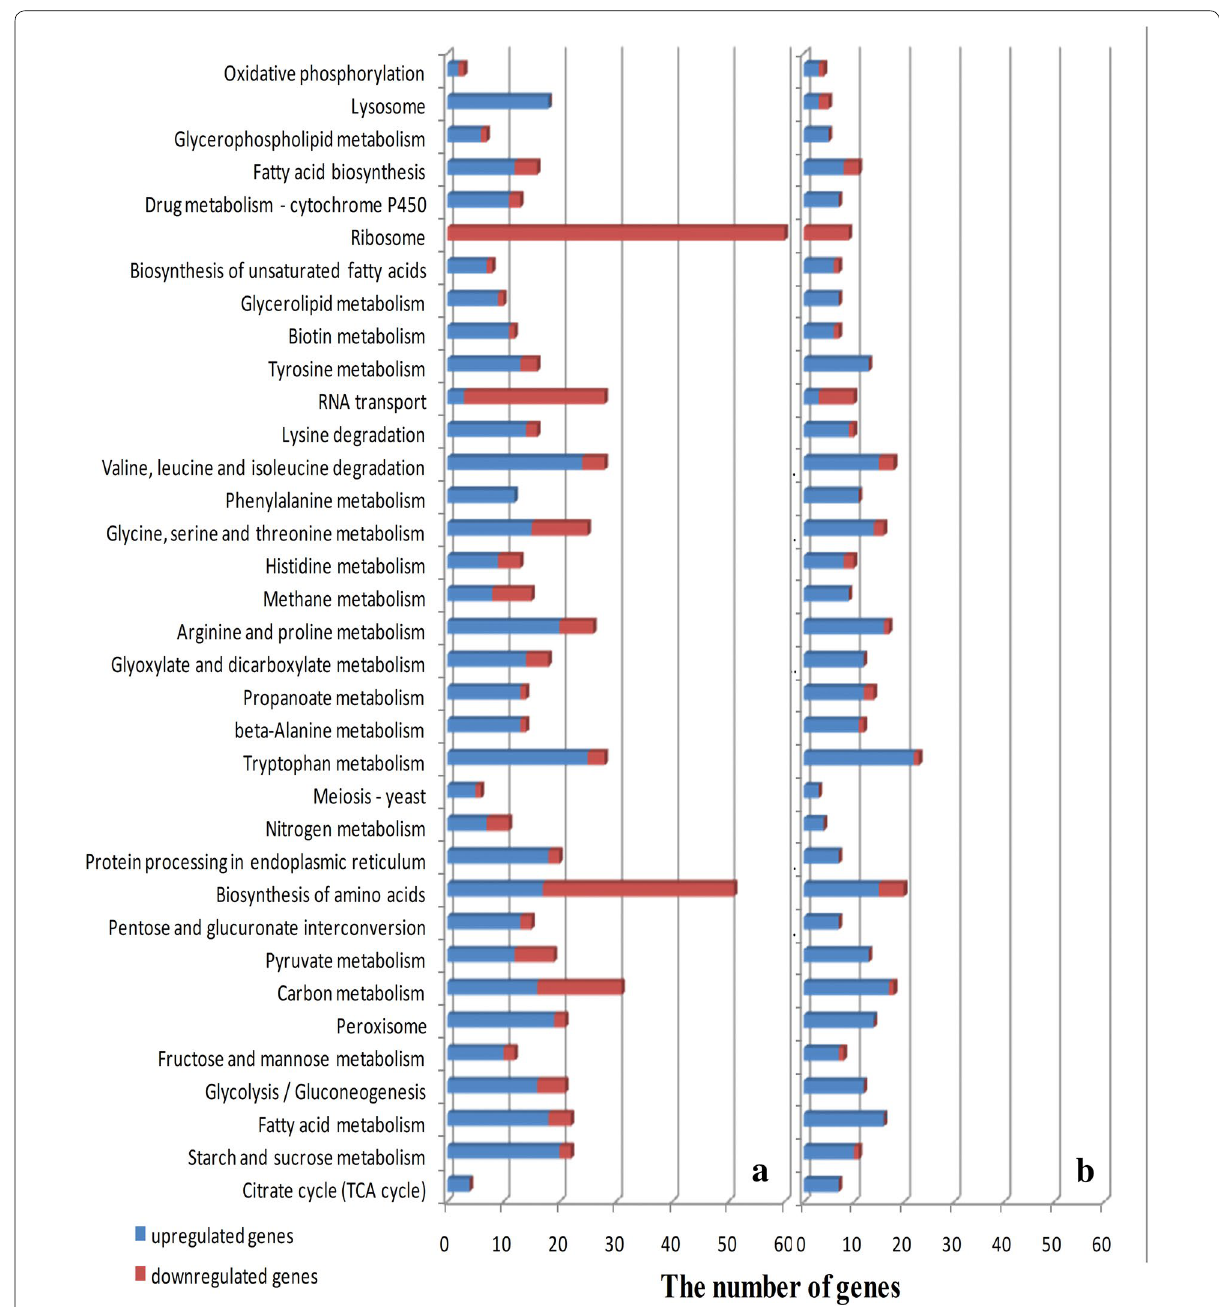
Fig. 3 Comparative transcriptomic data at the stage of 10 h clustered by KEGG categories. a Comparative transcriptomic data of strain YX‑1217 versus ATCC 1015 ( S 1/ S 3) at the stage of conidia germination (10 h culture of conidia in seed medium) clustered by KEGG categories; b Compara‑ tive transcriptomic data of strain YX‑1217 versus YX‑1217G ( S 1/ S 2) at the stage of conidia germination (10 h culture of conidia in seed medium) clustered by KEGG